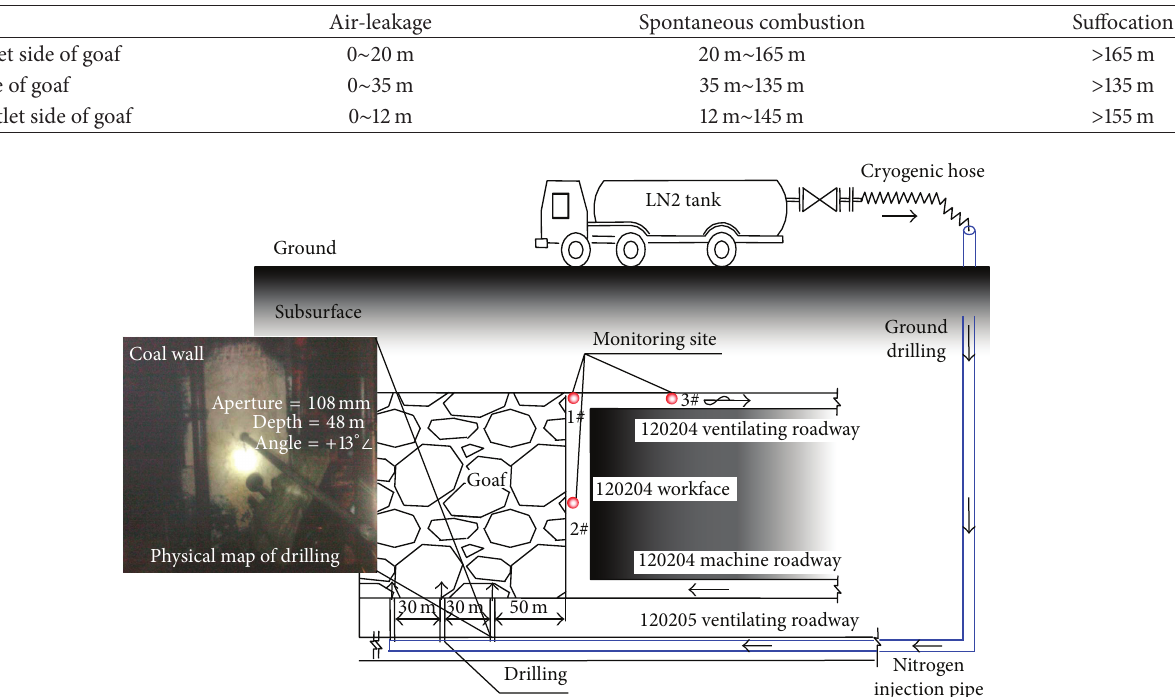
Table 3: Spontaneous combustion hazard zone of goaf.